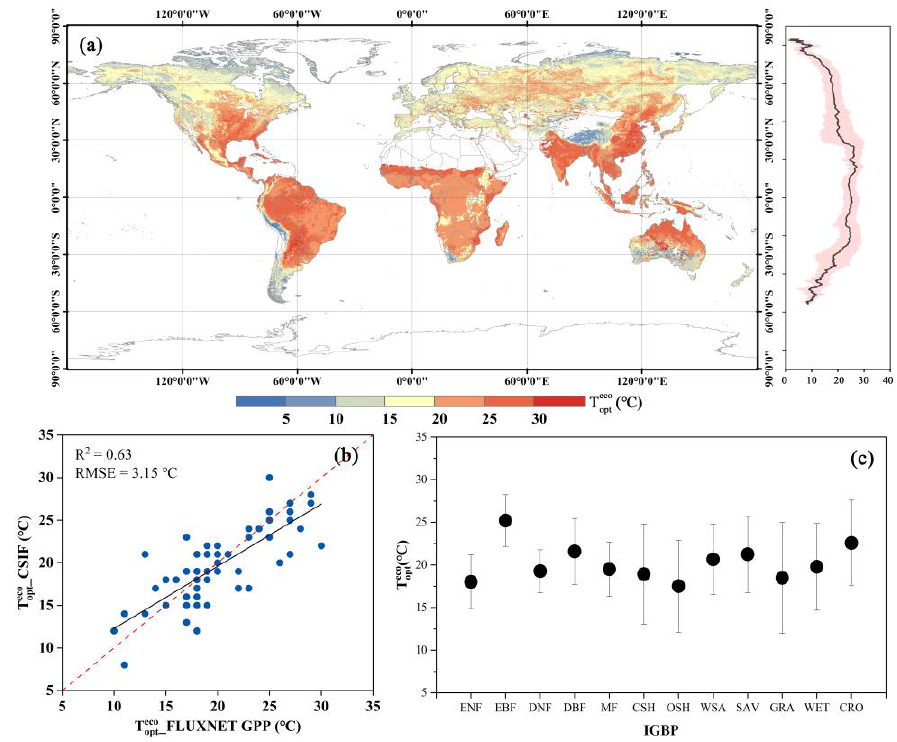
Figure 3. (a) Global ecosystem-scale optimum temperature for photosynthesis ( T opteco ); (b) Relationship between in situ GPP and satellite SIF-derived T opteco ; (c) T opteco for different vegetation types. The vegetation types include evergreen needleleaf forest (ENF), evergreen broadleaf forest (EBF), deciduous needleleaf forest (DNF), deciduous broadleaf forest (DBF), mixed forest (MF), closed shrubland (CSH), open shrubland (OSH), woody savanna (WSAV), savanna (SAV), grassland (GRA), permanent wetland (WET), and cropland (CRO).